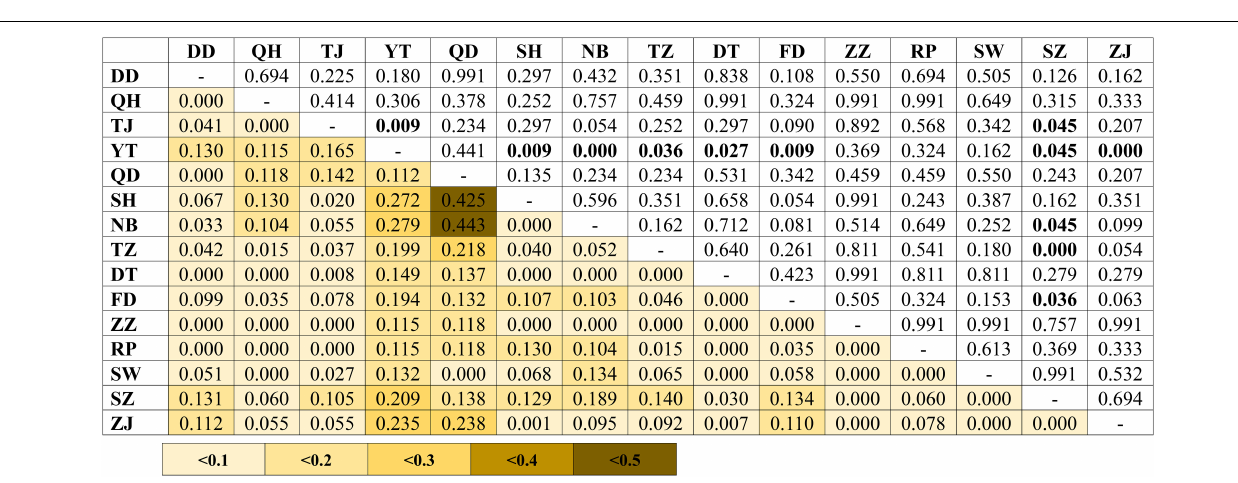
FIGURE 5 | Pairwise genetic differentiation ( F ST ; below diagonal) between the populations of Tridentiger bifasciatus in the China Seas based on the nuDNA dataset. Significant pairwise p- values (above diagonal) are shown in bold ( p < 0.05) after the Bonferroni correction. See Table 1 for the locality